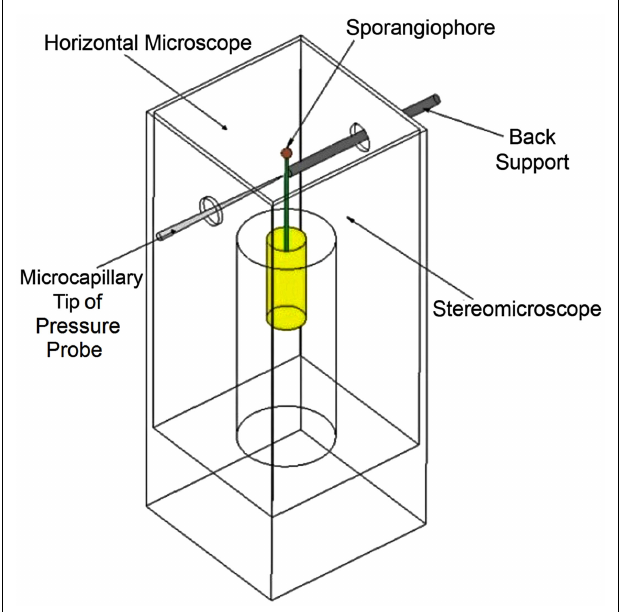
FIGURE 2 | Experimental apparatus for pressure probe experiments. A stage IVb sporangiophore is inserted into a holder within the chamber where it is adapted (see “Protocol for in vivo creep experiments” in the Materials and Methods for details). A back support (metal rod) supports the sporangiophore stalk while the microcapillary tip of the pressure probe impales the stalk below the growth zone. A stereomicroscope is used to observe cell sap-oil interface and a horizontal microscope is used to measure the elongation as a function of